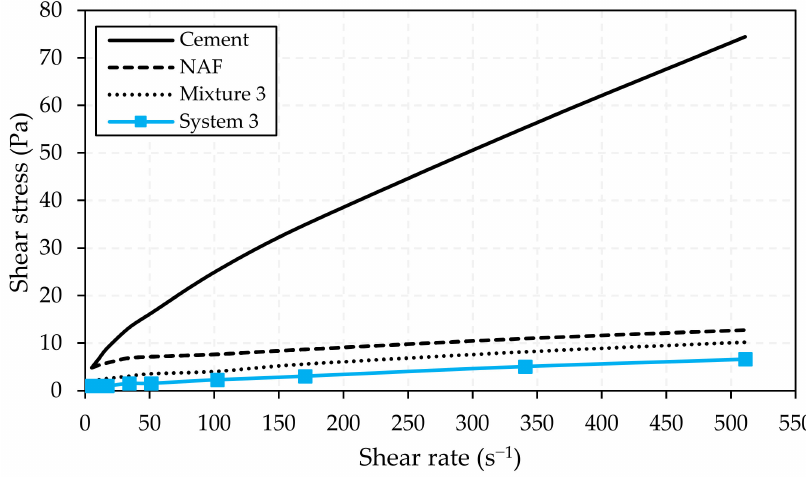
Figure 13. Rheological behavior of cement / NAF / mixture and cleanup fluid: system 3.